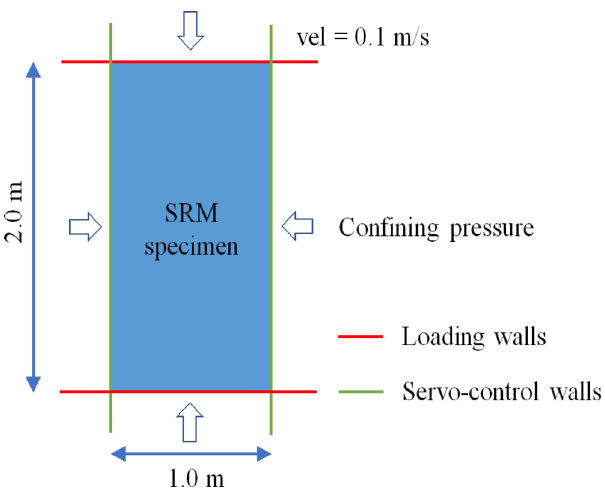
Fig. 4 Schematic of numerical model used to perform triaxial com- pression